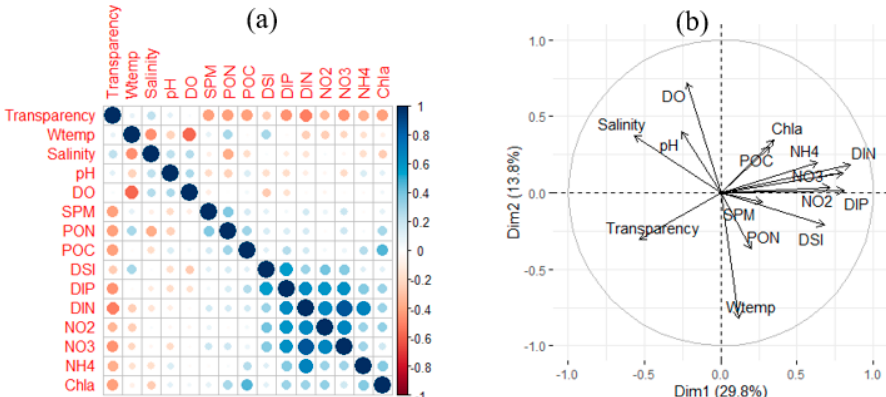
Figure 7. Exploratory data analysis; ( a ) correlation matrix plot, ( b ) loading plot of PCA. Abbreviations: Wtemp, water temperature; pH, hydrogen ion concentration in water; DO, dissolved oxygen; SPM, suspended particulate matter; POC, particulate organic carbon; PON, particulate organic nitrogen; DSI, dissolved silicate; DIP, dissolved inorganic phosphorus; DIN, dissolved inorganic nitrogen; Chl- a , chlorophyll- a concentration.